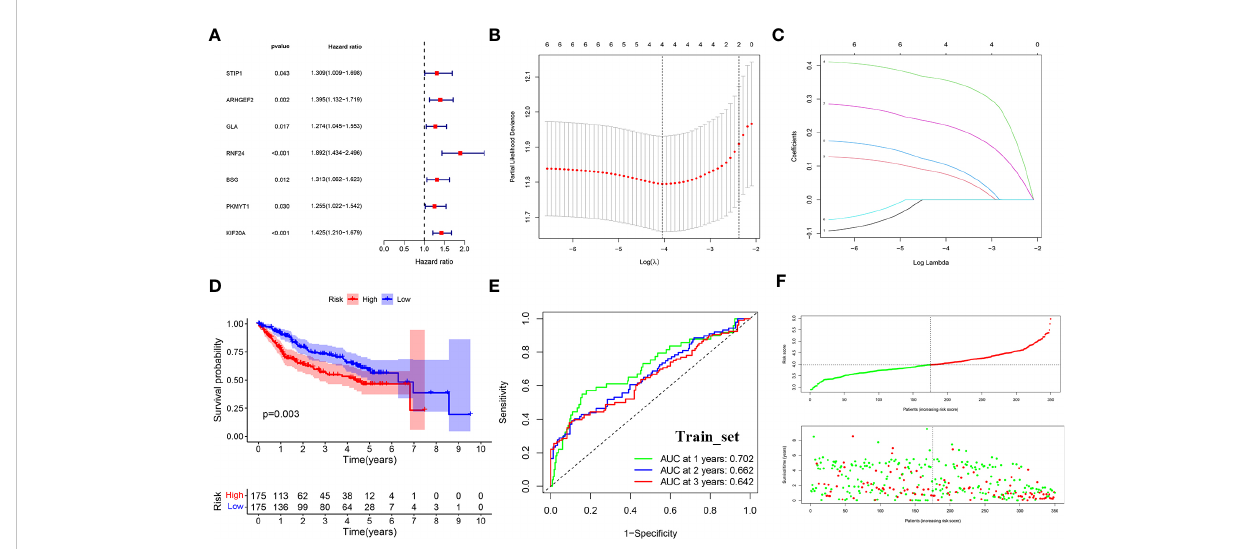
FIGURE 5 LASSO-COX regression to identify signature genes in the TCGA-Train set. (A) Forest plot of prognostic GARGs in the train set. (B) Cross-validation of the LASSO regression. (C) Coef fi cient value of prognostic genes. (D) Survival analysis between the high and low risk groups. (E) Receiver operating characteristic curve (ROC) of risk score. (F) Distribution of risk scores and survival